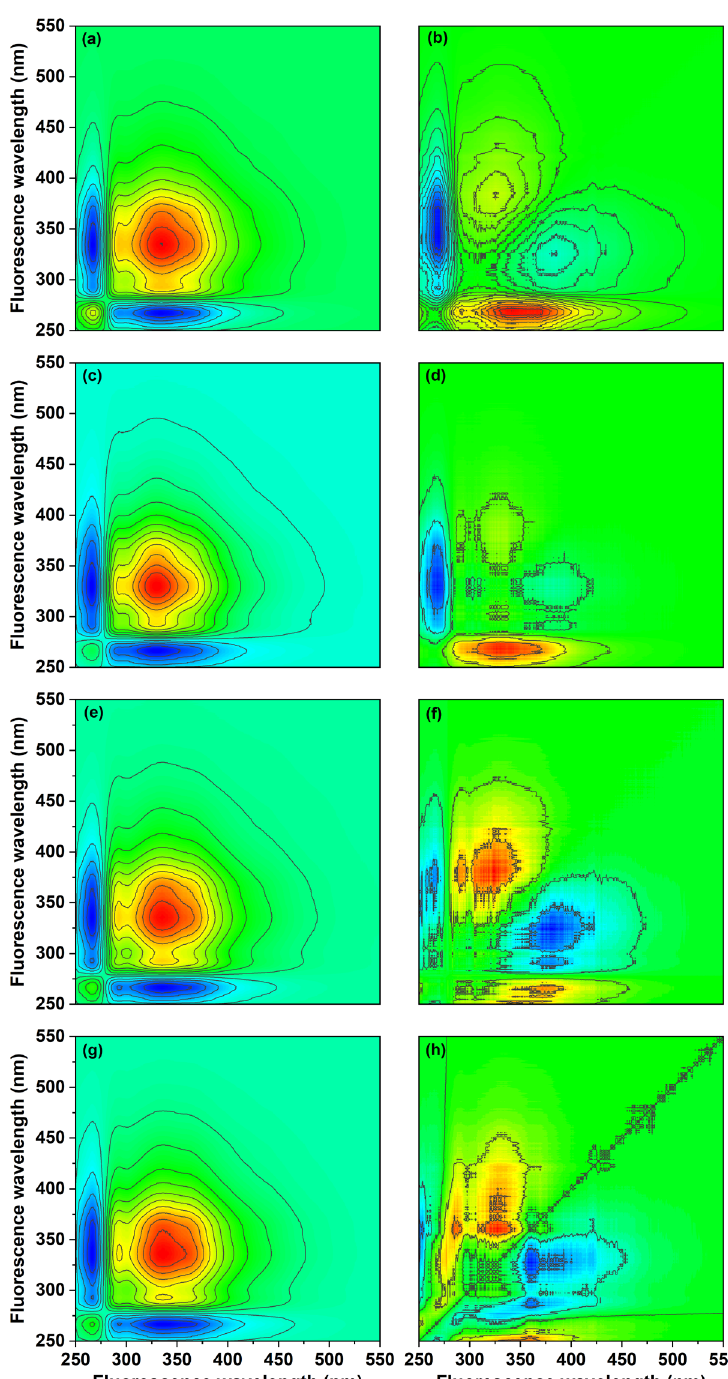
Figure 5. 2D-COS maps generated by synchronous fluorescence spectra of soil DOM in the 250–550 nm region. Synchronous map (CK: ( a ); 3BC: ( c ); 5BC: ( e ); 7BC: ( g )) and asynchronous map (CK: ( b ); 3BC: ( d ); 5BC: ( f ); 7BC: ( h )) for different treatment groups. CK, control; 3BC, 300 °C biochar treatment; 5BC, 500 °C biochar treatment; 7BC, 700 °C biochar treatment.